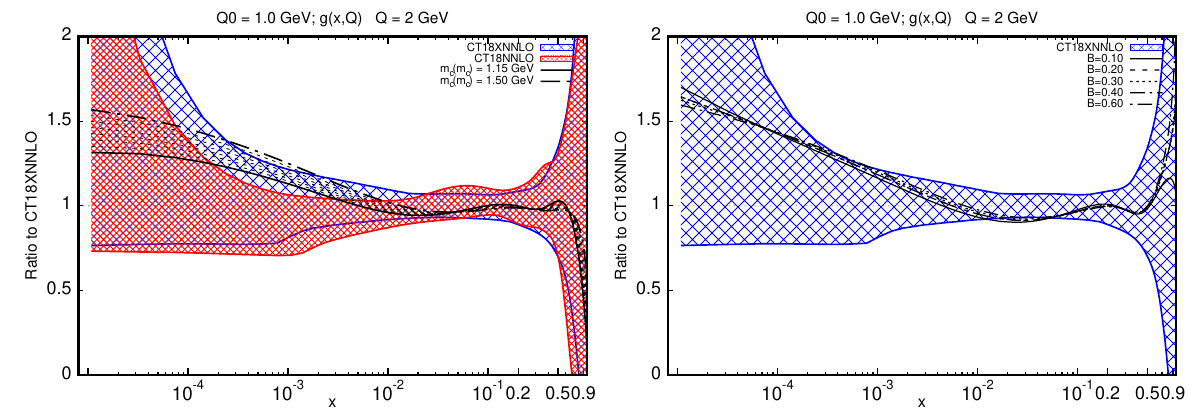
( m ) while m ( m ) = 4.18 c c b b ( x ) . Error bands are shown at 90% DIS